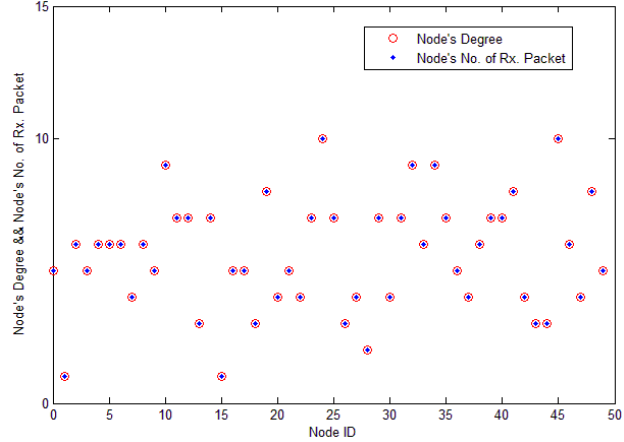
Figure 5. Each node’s number of receiving packets is nearly equal to each node’s degree. Each node’s load in the basic flooding process is quite different. Nodes with high degree generate more traffic loads than nodes with low